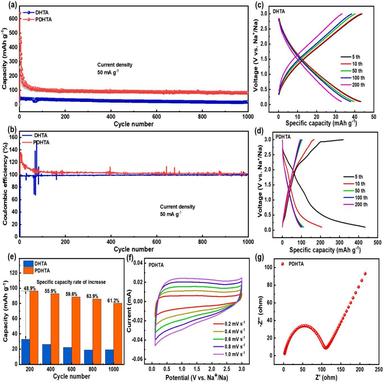
(a, b) Cycle performance and Coulombic efficiency over 1000 cycles for DHTA and PDHTA; (c, d) Charge-discharge profiles of DHTA and PDHTA at different cycle numbers; (e) Bar chart showing the specific discharge capacity of DHTA and PDHTA; (f) Charge-discharge profiles of PDHTA at different cycle numbers; (g) EIS analysis of the PDHTA electrode.